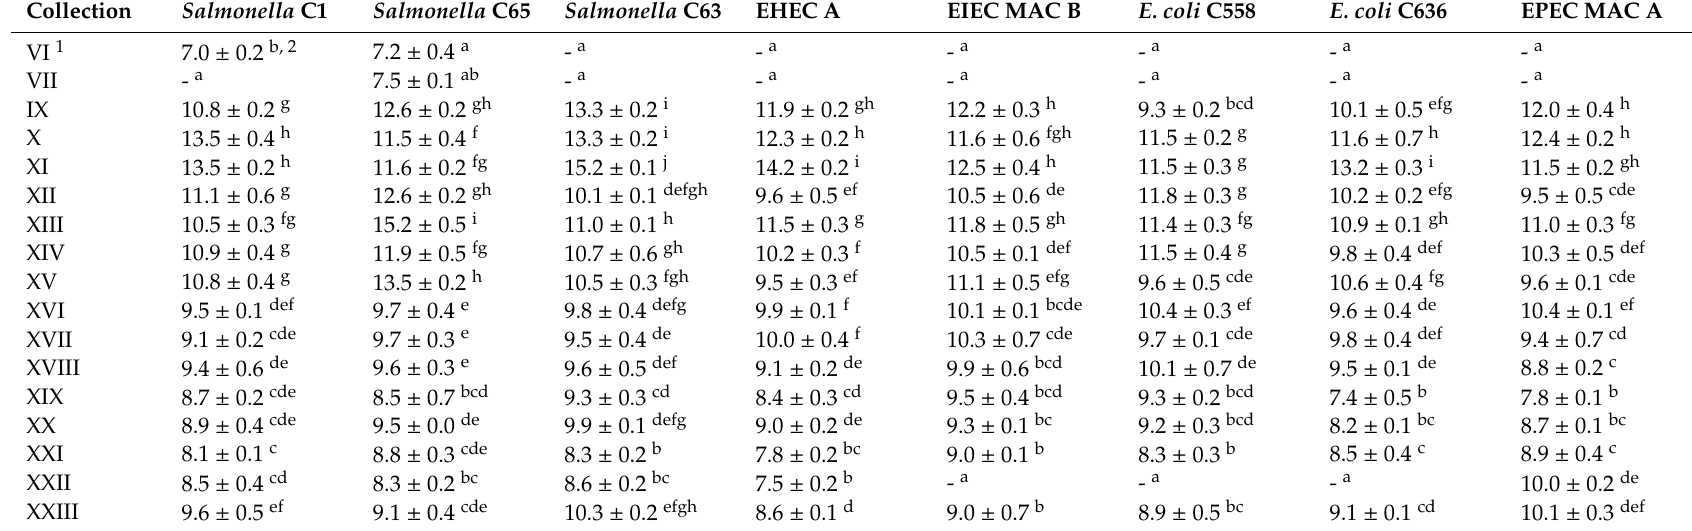
Table 3. Anti-microbial e ff ect of chromatographic fraction collections from Hibiscus sabdari ff a calyx acetonic extract against eight multidrug-resistant Salmonella and pathogenic Escherichia coli